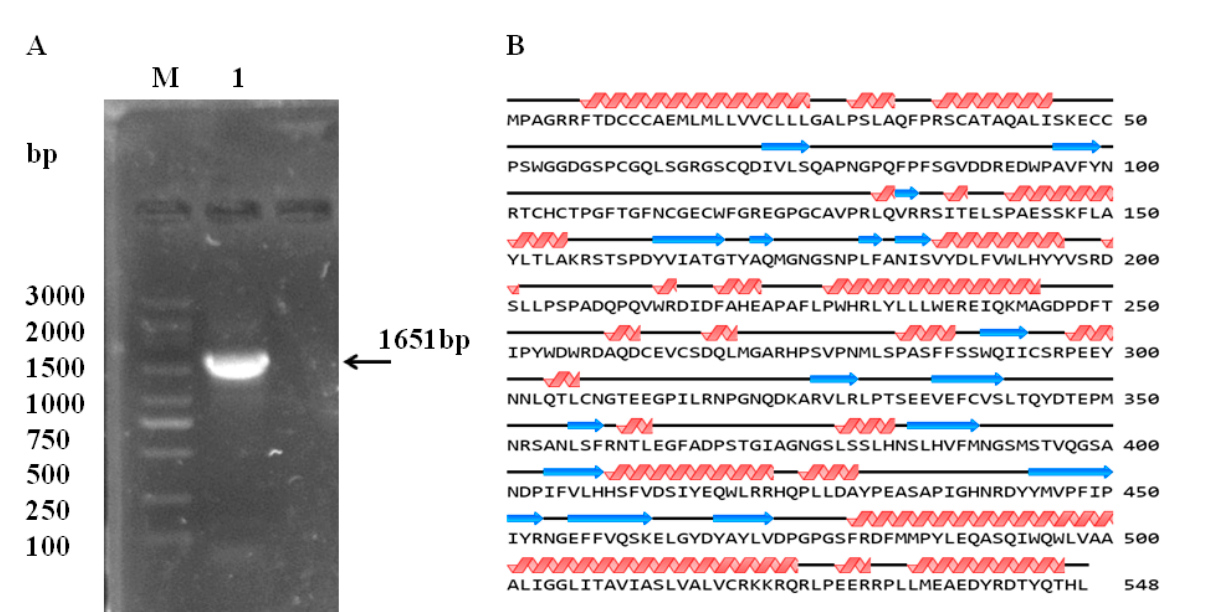
Figure 9. TYR gene clone and sequence characterization. ( A ) Agarose gel electrophoresis of TYR, M: DL3000 DNA marker, Lane 1: amplification fragment of TYR; ( B ) secondary structure prediction of TYR protein. : helix;